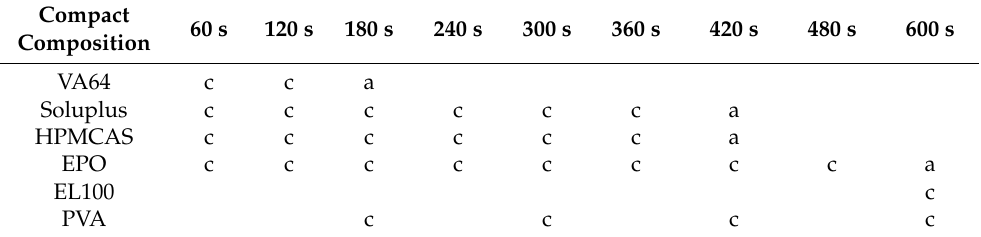
c: Indicates residual crystallinity detected by XRPD. a: Indicates amorphization detected by XRPD. Note: Compacts containing HPMCAS, EPO, and Soluplus were not stable and showed signs of recrystallization after 1.5–2 weeks under nonspecific storage conditions; this indicates the formation of a supersaturated ASD at room